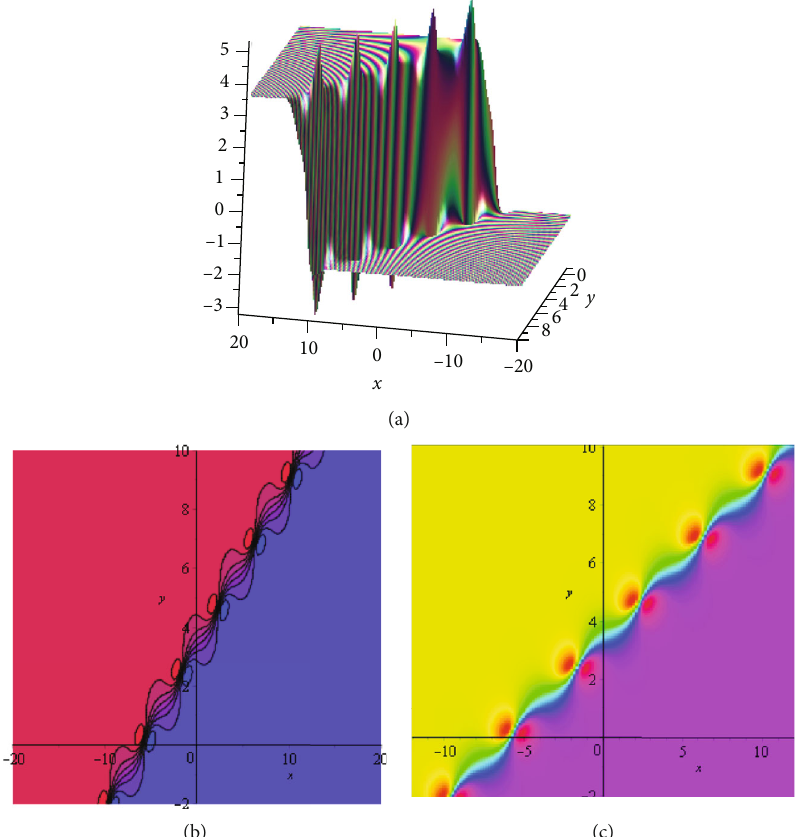
= : 5, a = 1 : 5, a = 2, a = 1, Ω = 1 : 1, Ω = 1 : 2, δ = 1, δ = 1 : 3, δ = 2, δ 1 2 3 4 4 7 1 2 3 4